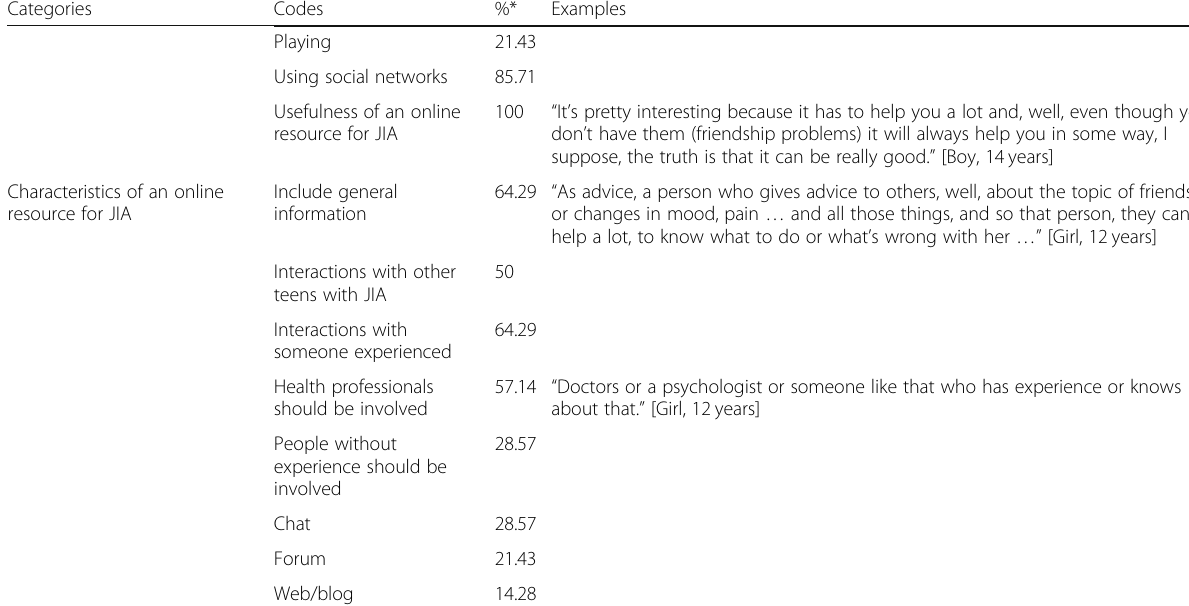
Table 4 Categories and codes identified (interviews) (Continued)